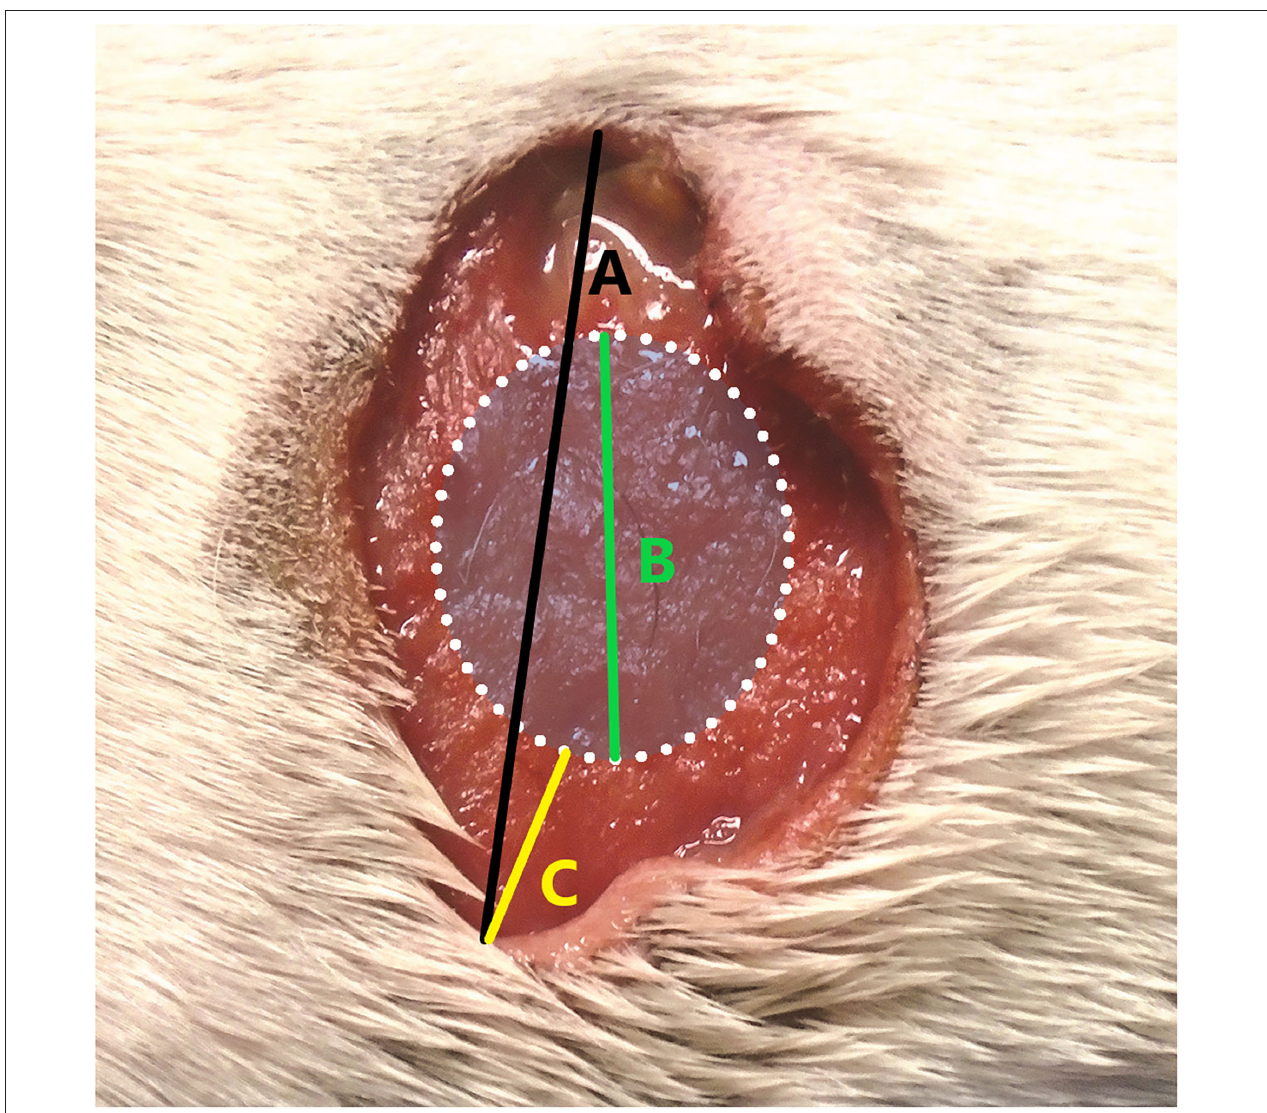
FIGURE 1 | Example of calculating the tigilanol tiglate (TT) margin [TT Margin (cm) ] where (A) is the maximal diameter of the tissue deficit (cm), (B) is the maximal tumour diameter at treatment (cm), and (C) is the calculated TT margin (cm).